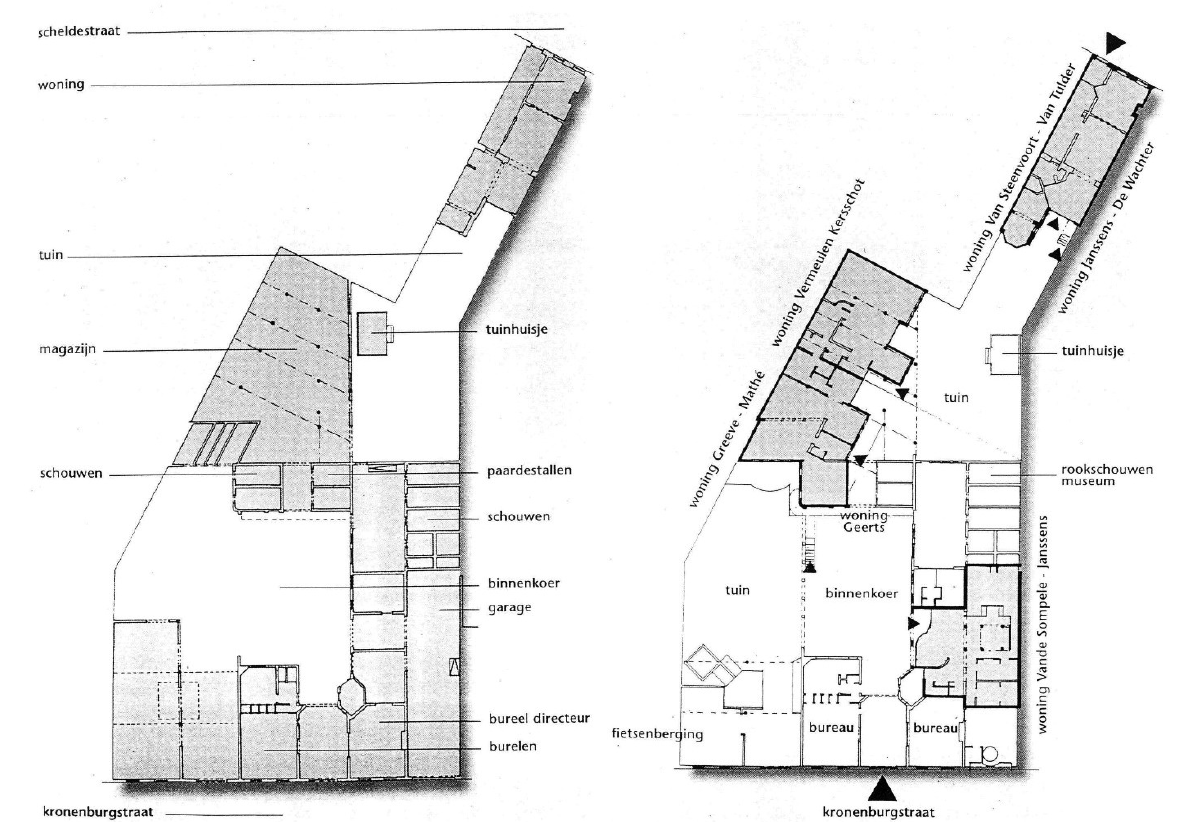
Figure 4. Original plan of the Herring Smoking Factory, with annotations by the inhabitants (left), and CH plan by Stramien and Archi‐3, 1984 (right). Source: Courtesy of Peter